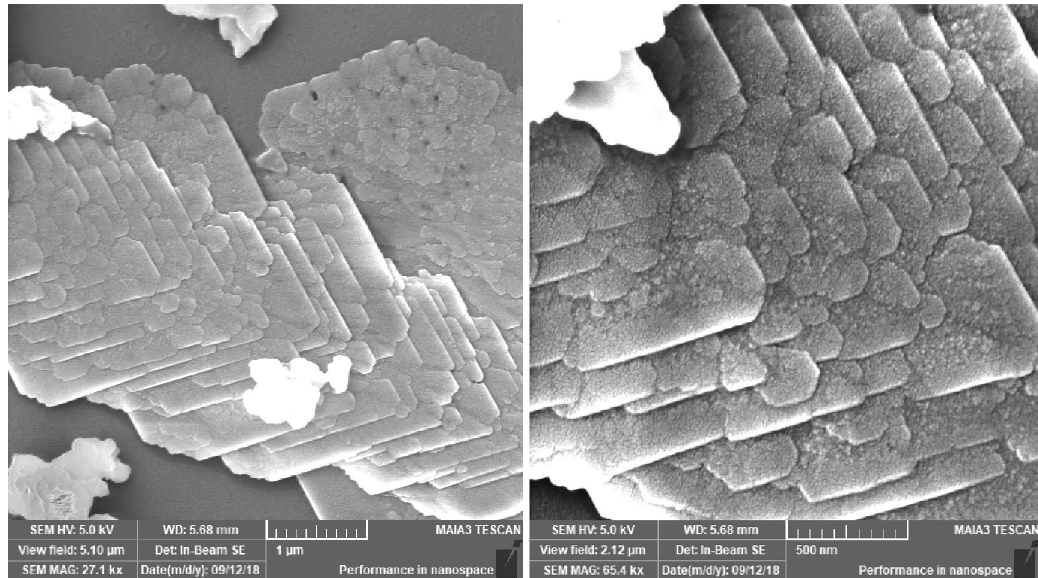
Figure 5. FESEM image as-formed Copper Oxide nanosheets.